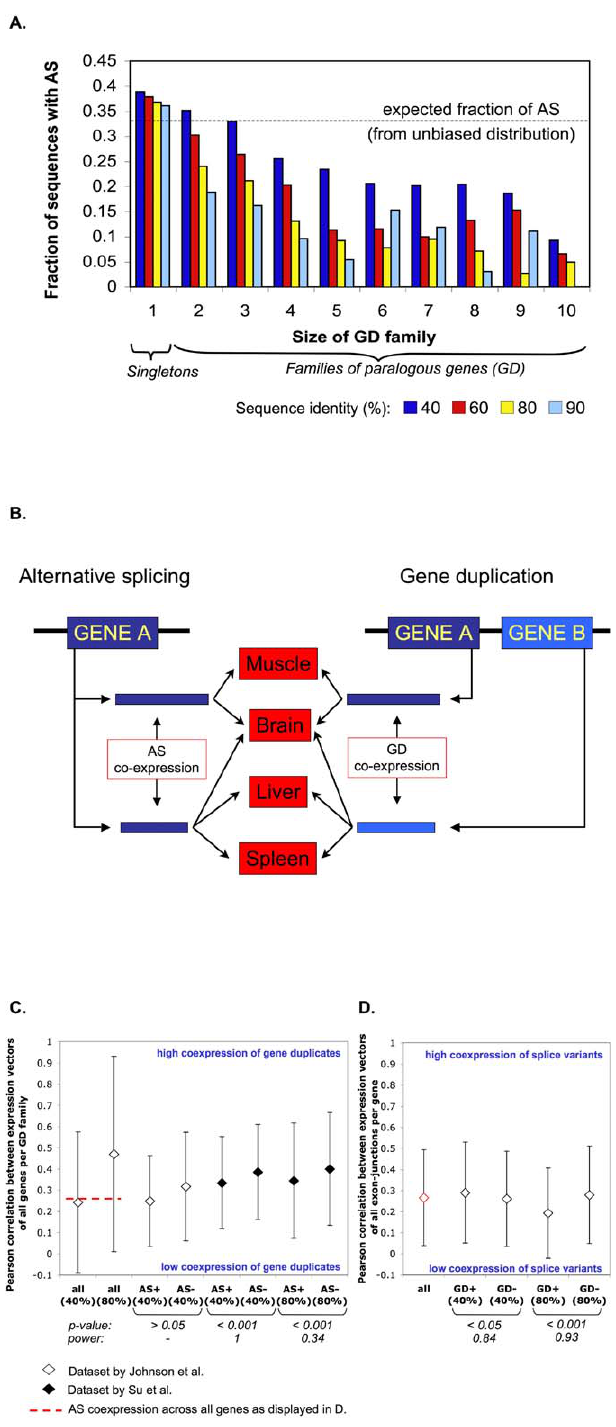
Figure 2. The Relationship between AS and GD at the Genomic Level (A) The diagram shows the uneven distribution of AS amongst GD families of different sizes for the human genome. Information on AS has been taken from the AltSplice database [43]. GD families were obtained by clustering all sequences of more than 40%, 60%, 80%, or 90% seq.id., respectively, using CD-HIT [47]. The dashed line marks the expected fraction of genes with AS, given an unbiased distribution of all known genes with splice variants across the whole genome. In accordance with previous results [12,13], for large GD families we observe fewer genes with AS than expected at random. (B) The cartoons illustrate that alternative splice isoforms and gene duplicates may be expressed in the same number and/or types